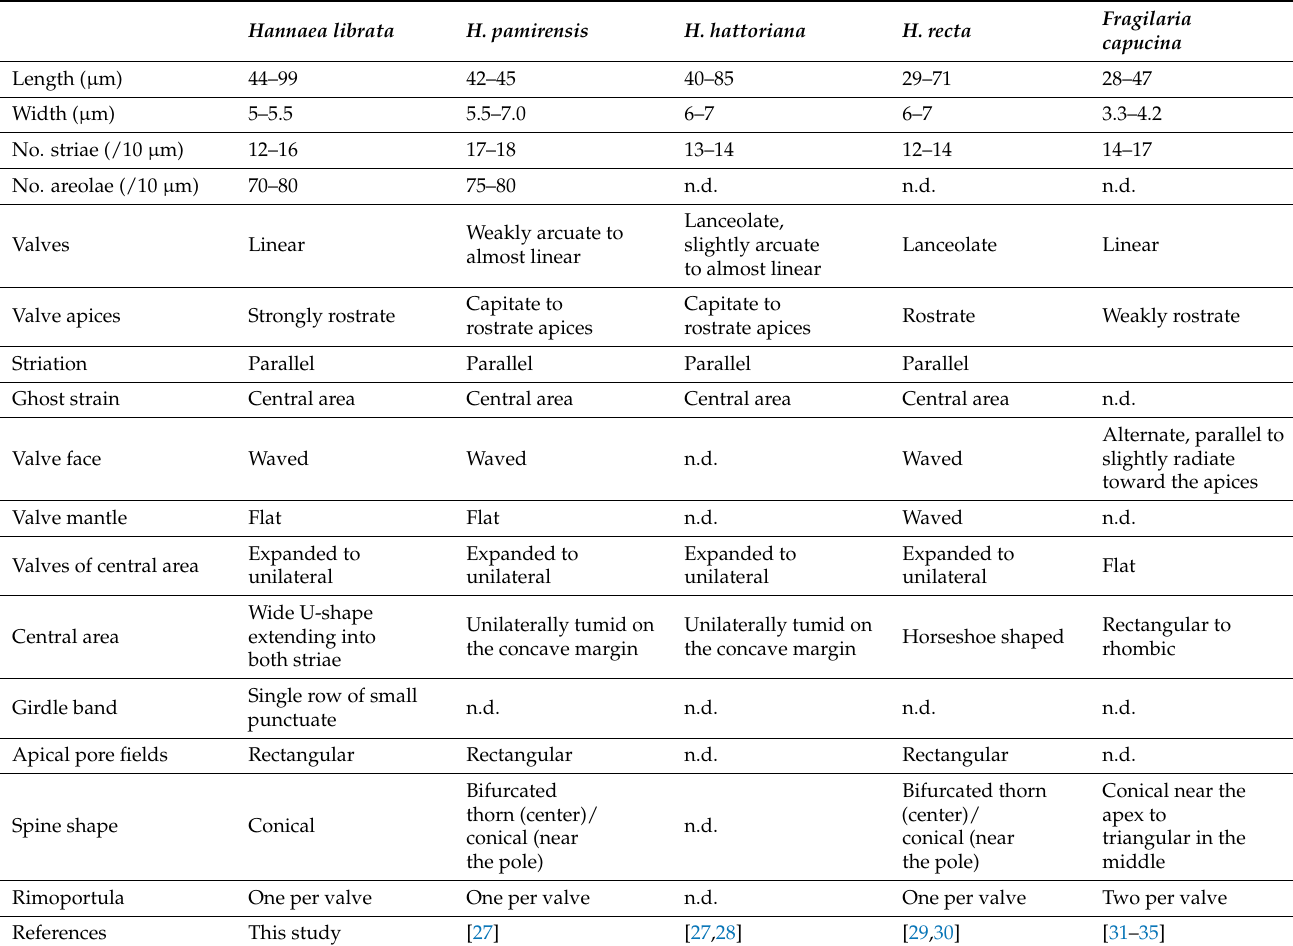
Table 2. Comparison of morphological characteristics for Hannaea librata nov. and closely re- lated